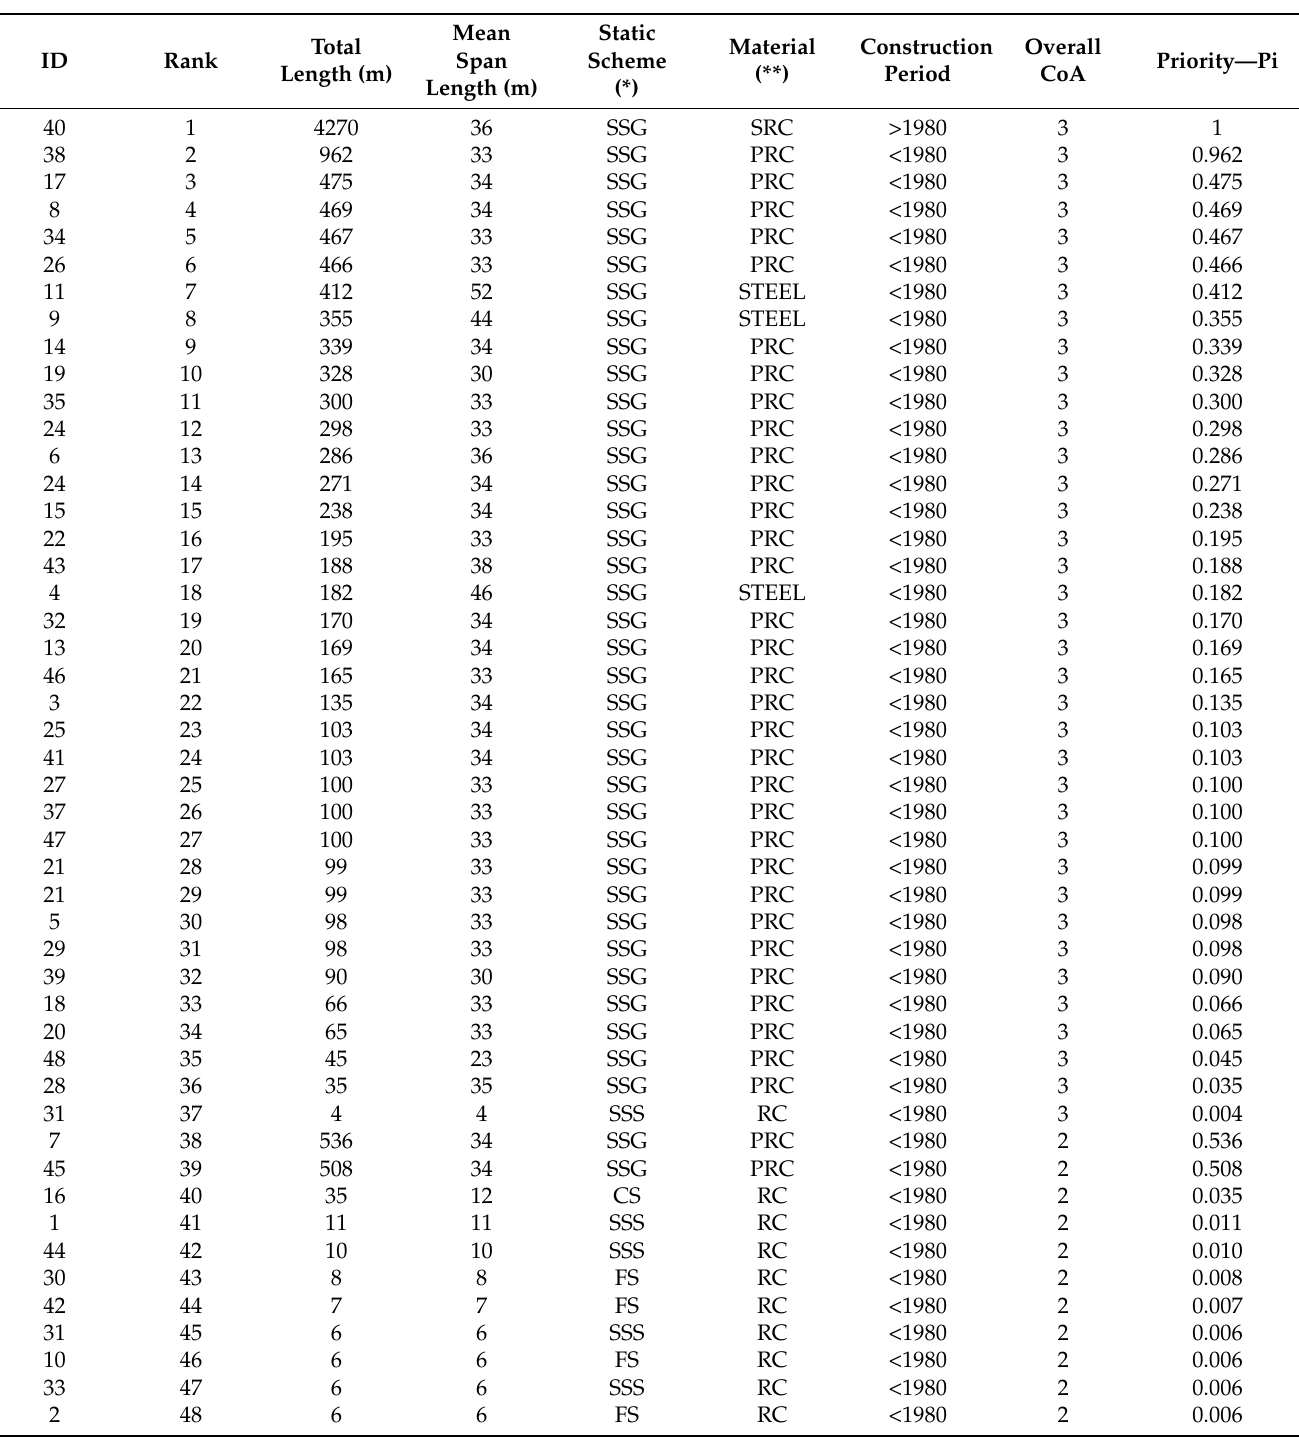
Table 7. Priority ranking for low degradation